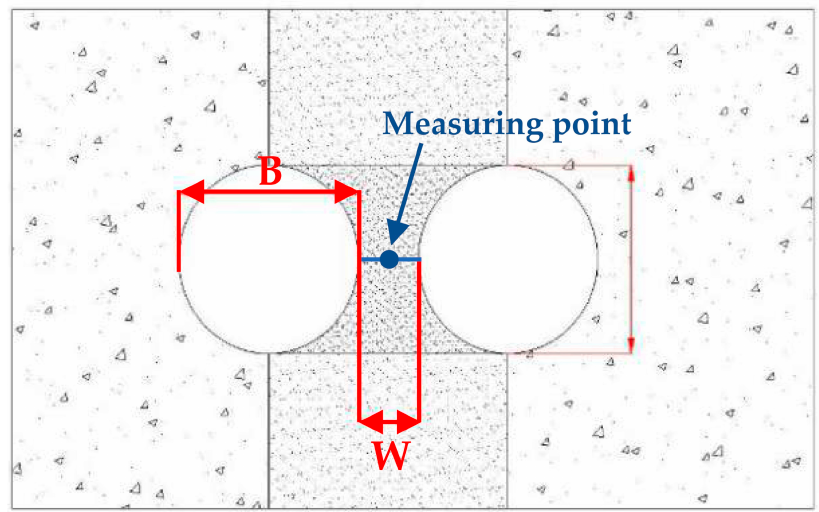
Figure 1. Schematic diagram of the middle rock pillar in a small clear-distance tunnel.